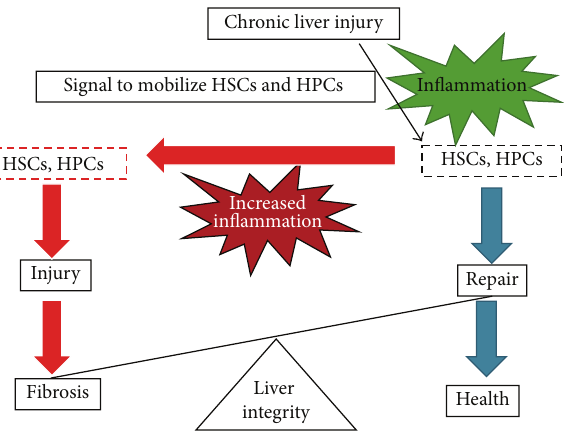
Figure 8: The schematic representation of the balance of HSCs and HPCs between injury and repair.